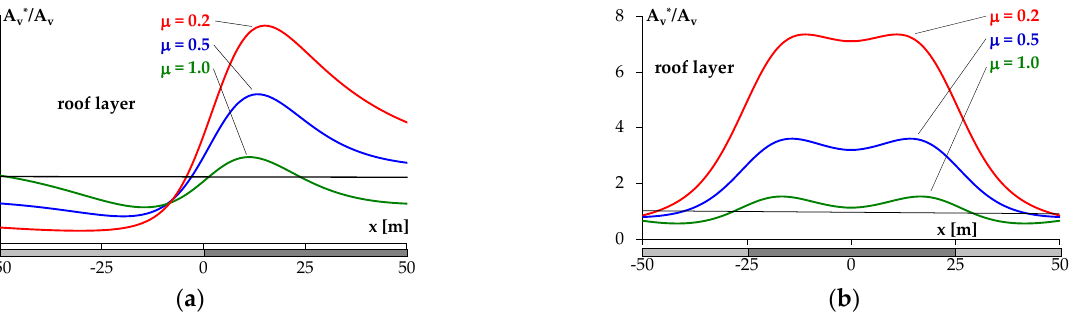
Figure 6. Distribution of the energy concentration coefficient of volumetric strain for different strain